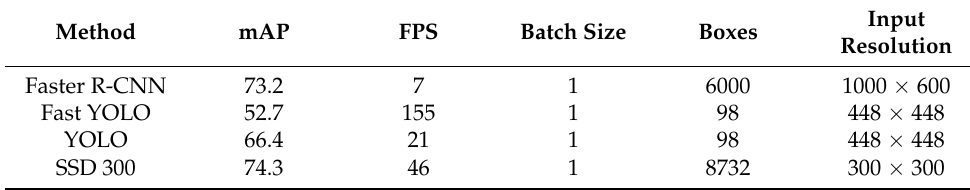
Table 2. Comparison of Deep Learning-based Object Detection Model Performance.